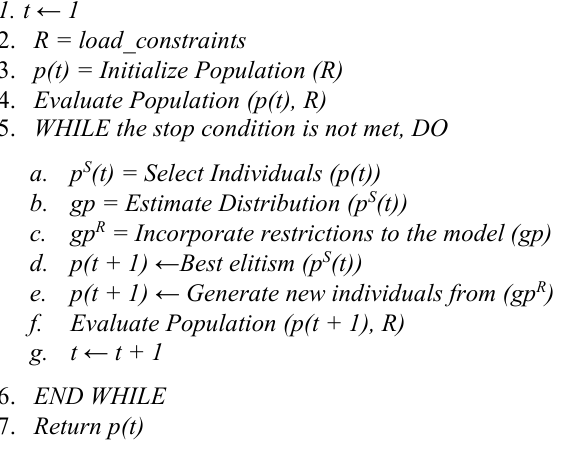
Algorithm 2. The pseudo-code of the algorithm proposed in this